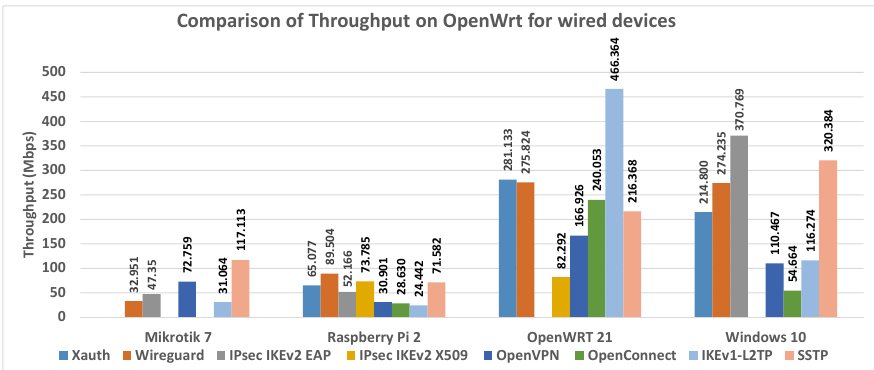
Figure 27. Throughputs data collected during the VPN connection tests with wired devices.